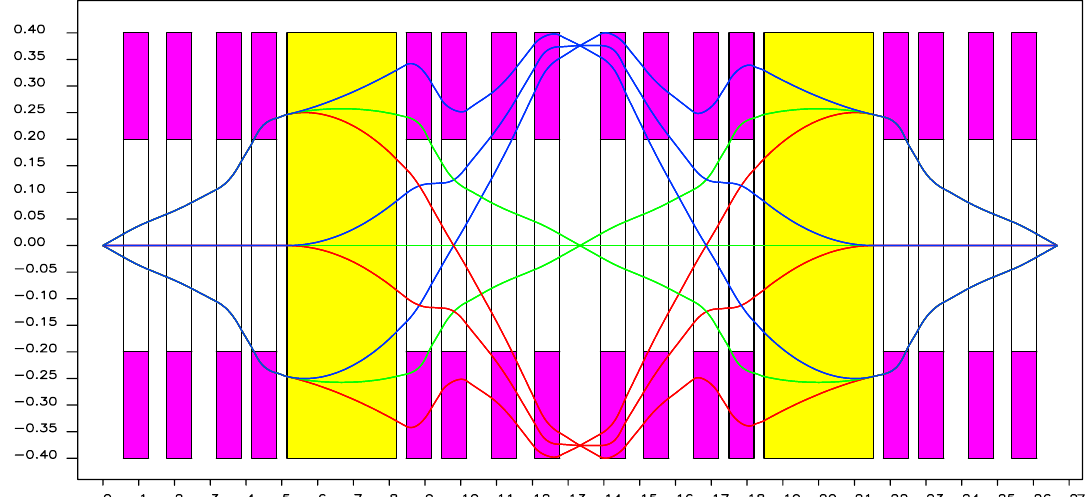
FIG. 1. (Color) First order horizontal beam envelope corresponding to an initial beam emittance of (cid:10) 1 mm , (cid:10) 50 mrad , and (cid:10) 16% energy dispersion. Yellow (light) boxes represent dipoles and the magenta (dark) boxes represent multipoles with appropriate apertures. The multipoles have two apertures: the larger (colored) represent the horizontal while the smaller (inner, white) represent the vertical apertures.